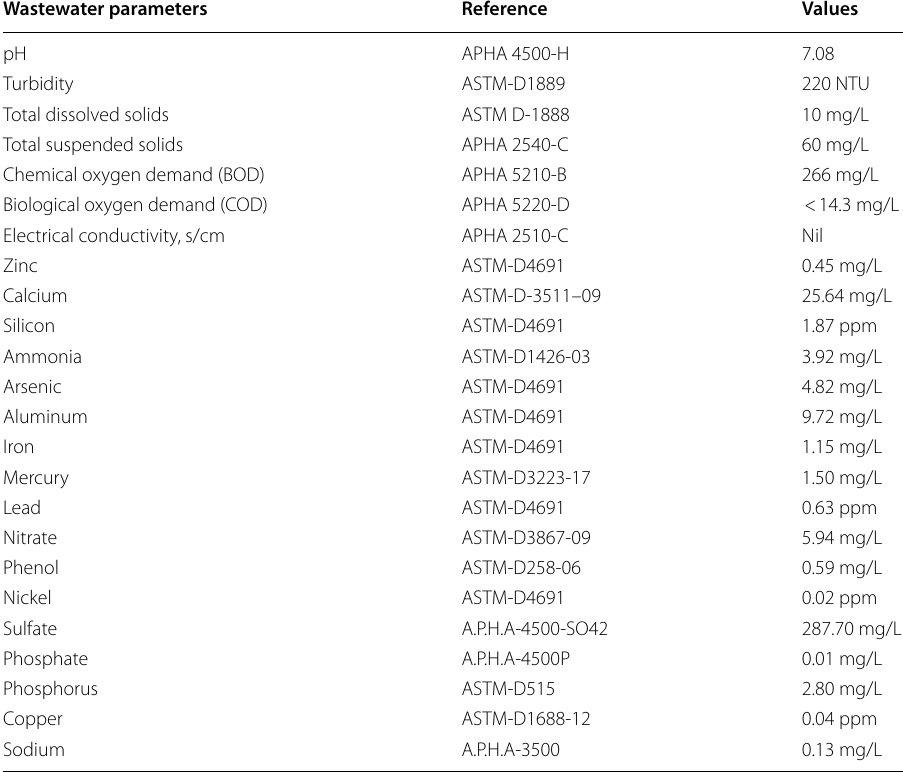
Table 2 Characteristics of the petroleum industrial effluent Wastewater